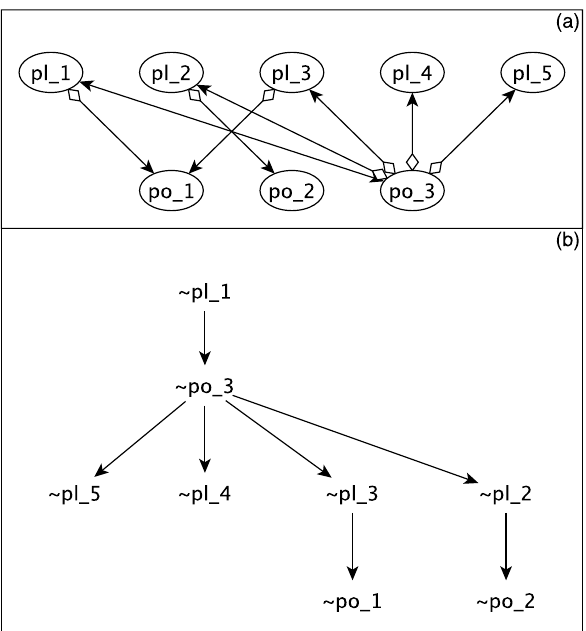
Figure 3. Breadth first search of the interaction network to find the LDOI of a (set of) fixed note state(s) in Boolean threshold functions governing the dynamics of plant–pollinator networks. ( a ) An interaction network with five plants and 3 pollinators. ( b ) The breadth first search in the case of starting from the node state ∼ pl_1. The nodes with incoming edges from pl_1 make up S 1 = { po_1, po_3 } . The second sufficiency check is satisfied for node state ∼ po_3, as a result ∼ po_3 ∈ LDOI ( ∼ pl_1). The same process is applied for node po_1, but none